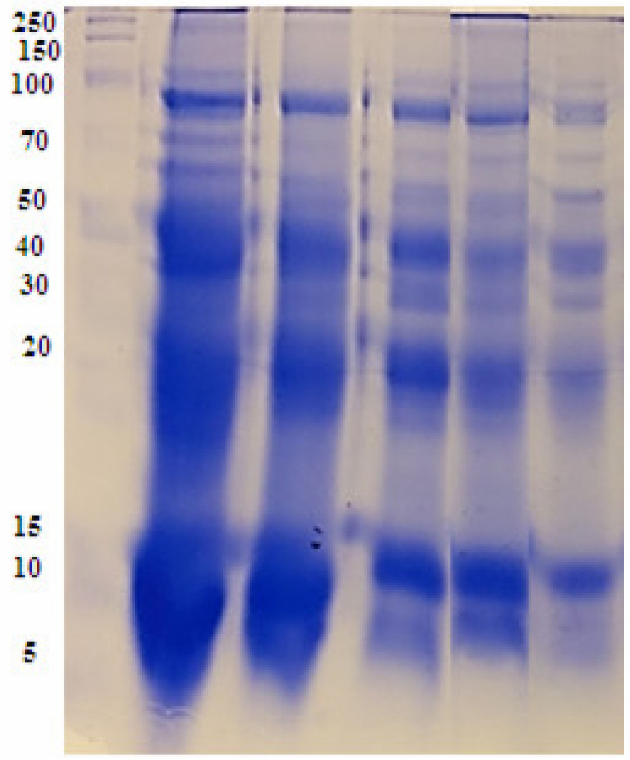
Figure 11. SDS-PAGE banding pattern protein in treated Vicia faba seeds. M: Marker, 1: control, 2: 3%